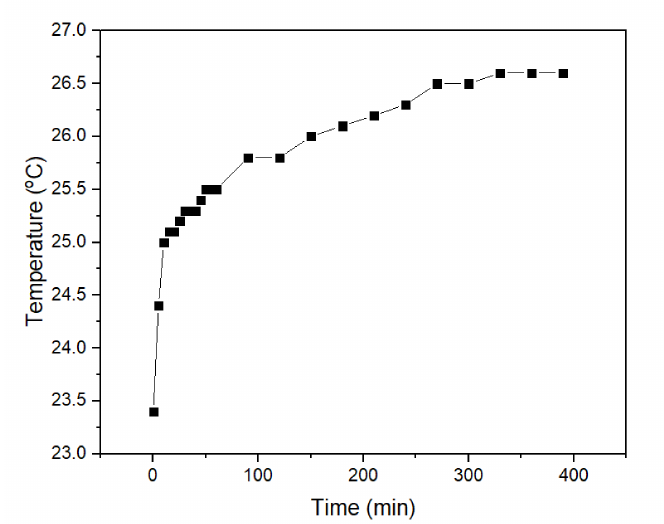
Figure 13. Surface temperature of the dedicated thermal pad (°C) against time